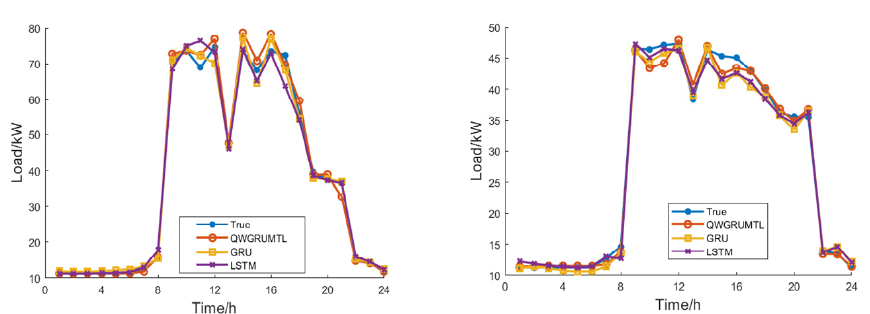
Figure 8. Forecasting curve of electrical load in summer.